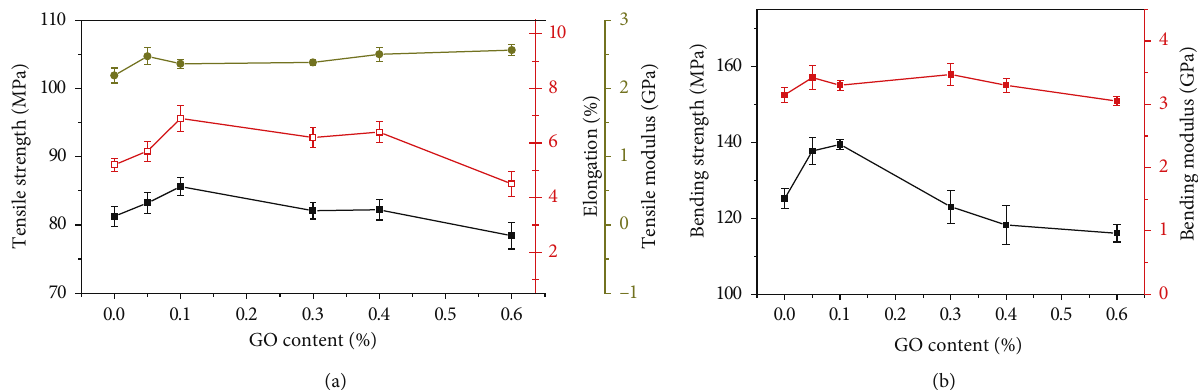
Figure 6: Variation in tensile strength, tensile modulus and elongation at break (a) and bending strength and bending modulus (b) with the increasing GO content in epoxy resin.